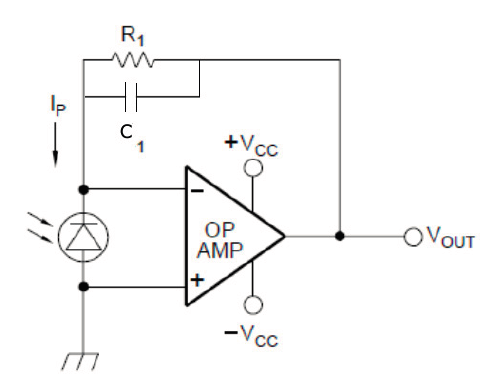
Figure 3. The photosensor circuit. A schematic of the low-cost photosensor circuit showing feedback resistor R 1 and noise filtering capacitor C 1